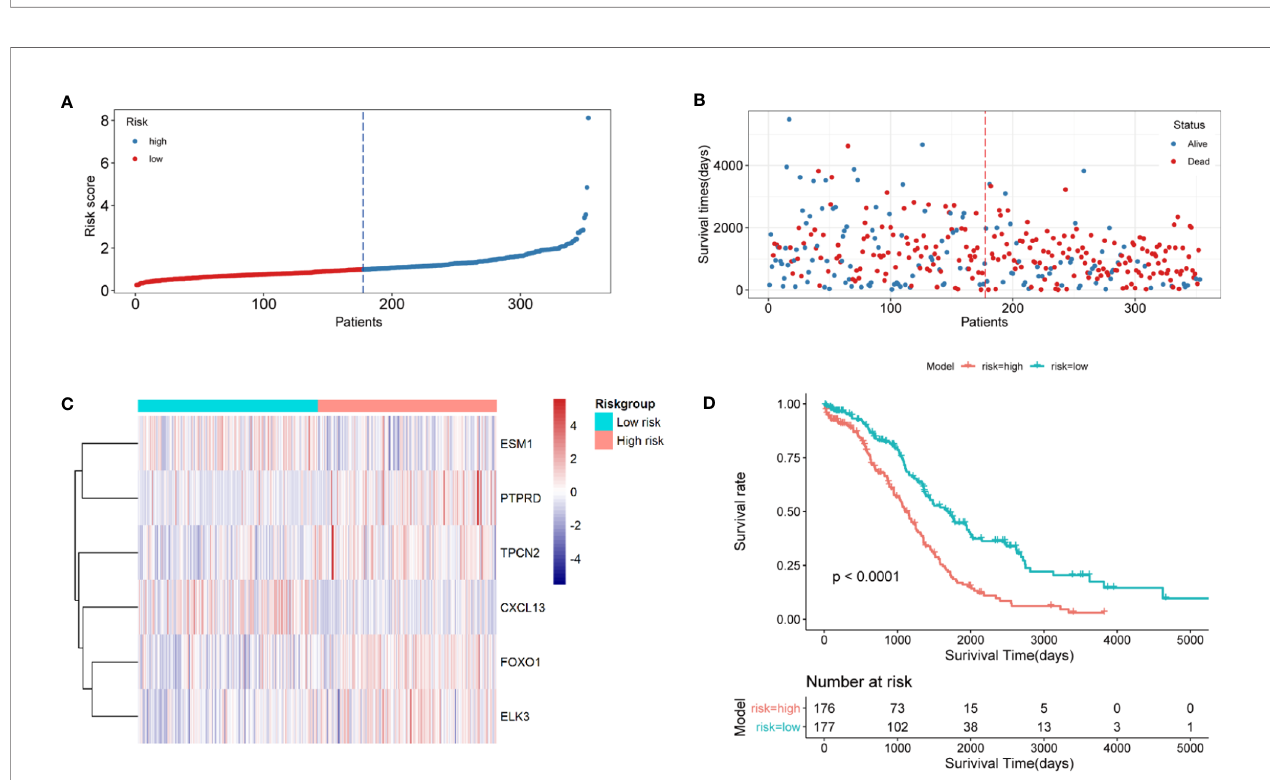
FIGURE 4 | Validation of ARG signature in the Xena-OC dataset. (A) Risk score distribution and high- and low-risk groups; (B) survival statuses in high- and low- risk groups; (C) heatmap of six AF-related genes in high- and low-risk groups; (D) time-dependent ROC curves in high- and low-risk